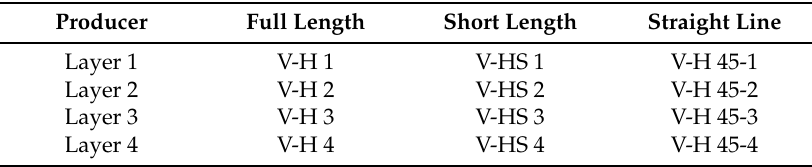
Table 3. Well pattern descriptions of the V-H case.